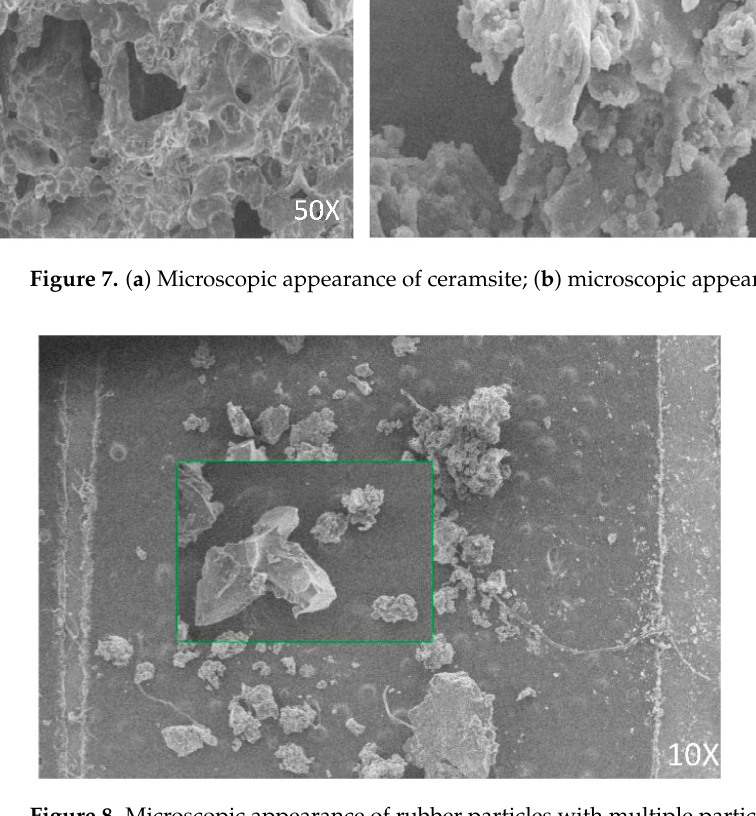
Figure 8. Microscopic appearance of rubber particles with multiple particle sizes.